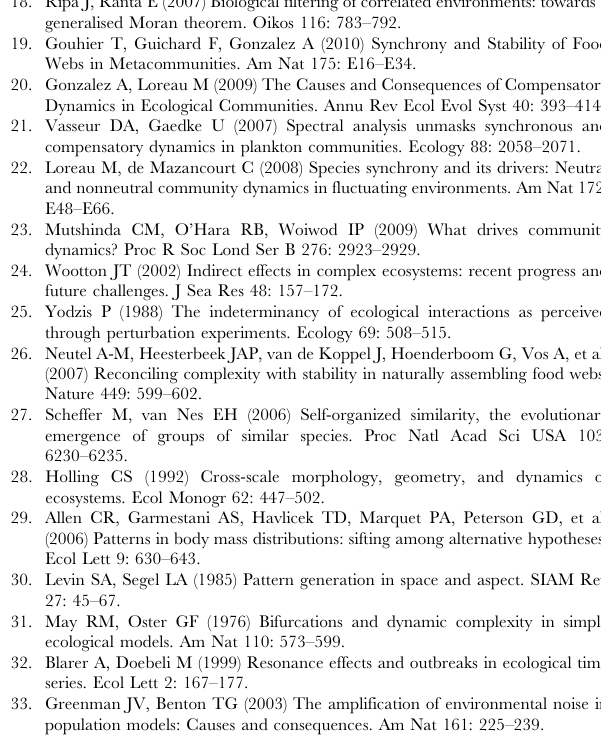
text. For all three cases, the species are logarithmically spaced between m =0.1 and m = 0.3, and the fixpoint dilution factor is a =0.001. The curves for 6 species are based on a single simulation; the ones for 10 and 15 species are averages of 5 simulations with different noise-series and starting abundances. Figure S10 The response of a fixpoint community to a perturbation in a . The plot shows the derivative dn k /d a (evaluated at the fixpoint) for all species k . The system responds very sensitively to changes in a ( dn k /d a , 6000), but the response shows little variation between species. Parameters as in Figures 3 and 4. Figure S11 Weighted and raw forms of the basic abundance perturbations. The upper row shows the weighted vectors ^ vv ( k ) for k = 1,8,15. The bottom row shows the corresponding unweighted eigenvectors v (k) .